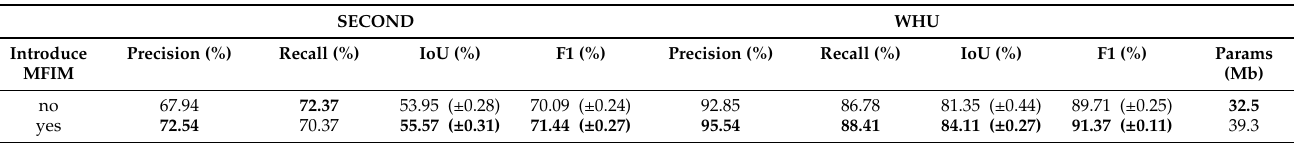
Figure 8. Visual comparisons of the baseline without/with the MFIM. ( a ) Inference results on the SECOND dataset. ( b ) Inference results on the WHU dataset. For better visualization, we show the missing changes with red and unexpected changes with blue. Table 1. The ablation study of introducing the MFIM. The symbol ± means the performance fluctua- tion. The values in bold font are the